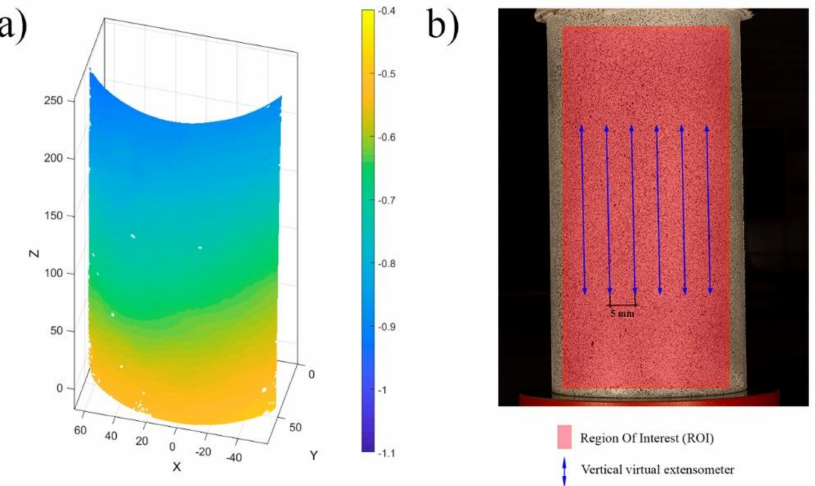
Figure 8. Results obtained during the 3D-DIC: ( a ) displacements obtained along the longitudinal axis; and ( b ) extraction of the maximum longitudinal strain by means of the virtual extensometer.